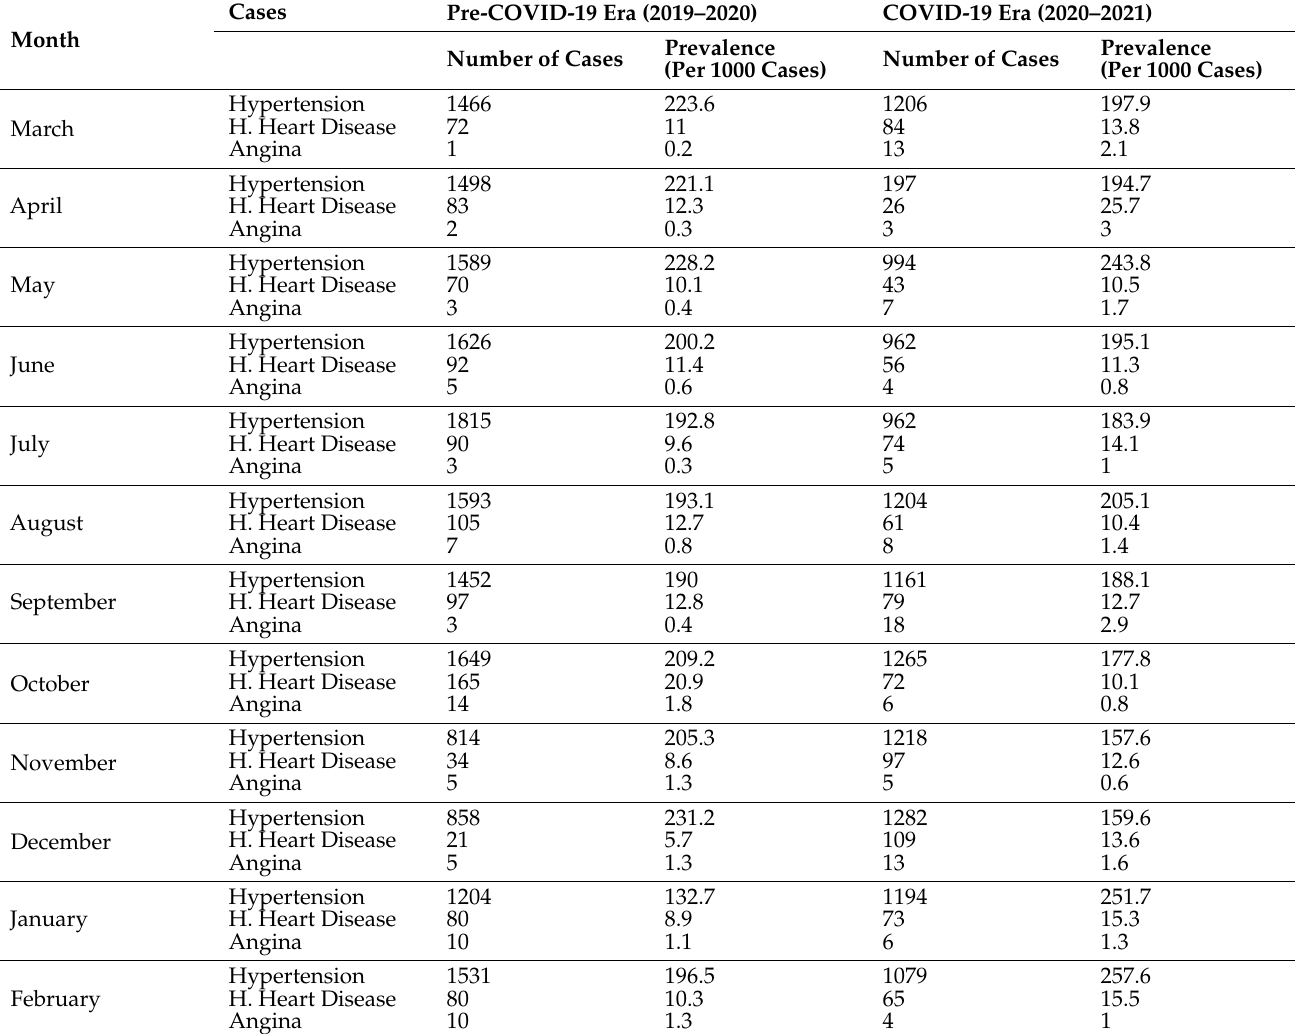
Table 4. Cases of cardiovascular diseases (hypertension, hypertensive heart disease, and angina) recorded in the pre-COVID-19 and COVID-19